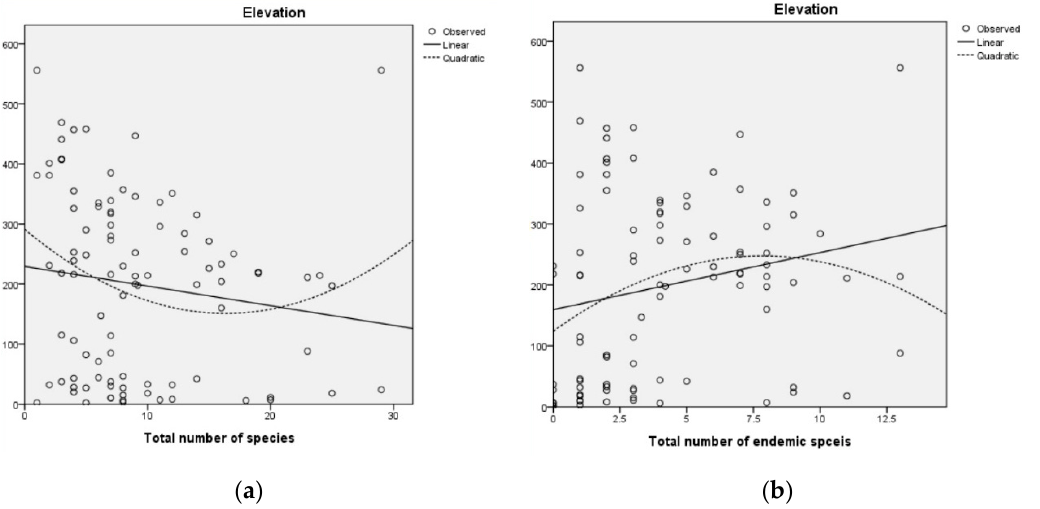
Figure 5. Relationships between elevation and total number of species ( a ) and total number of endemic species ( b ) at each study site of the adjacent areas of the DMZ. The solid line and dashed line indicated the relationship between elevation and total number of species, and between elevation and total number of endemic species, respectively.